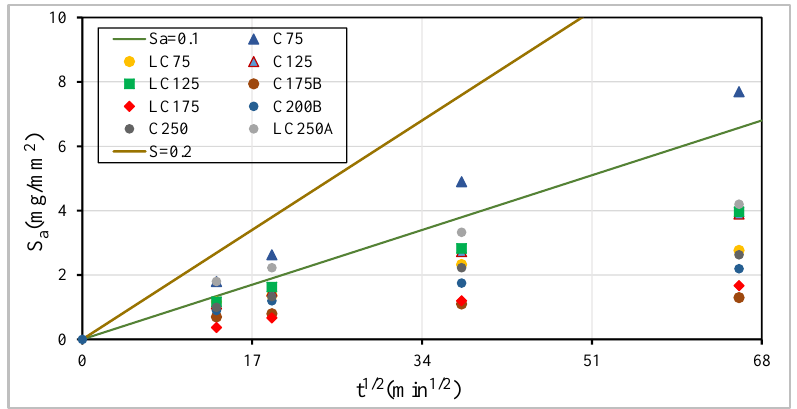
Figure 16. Capillarity water absorption through square root of time.